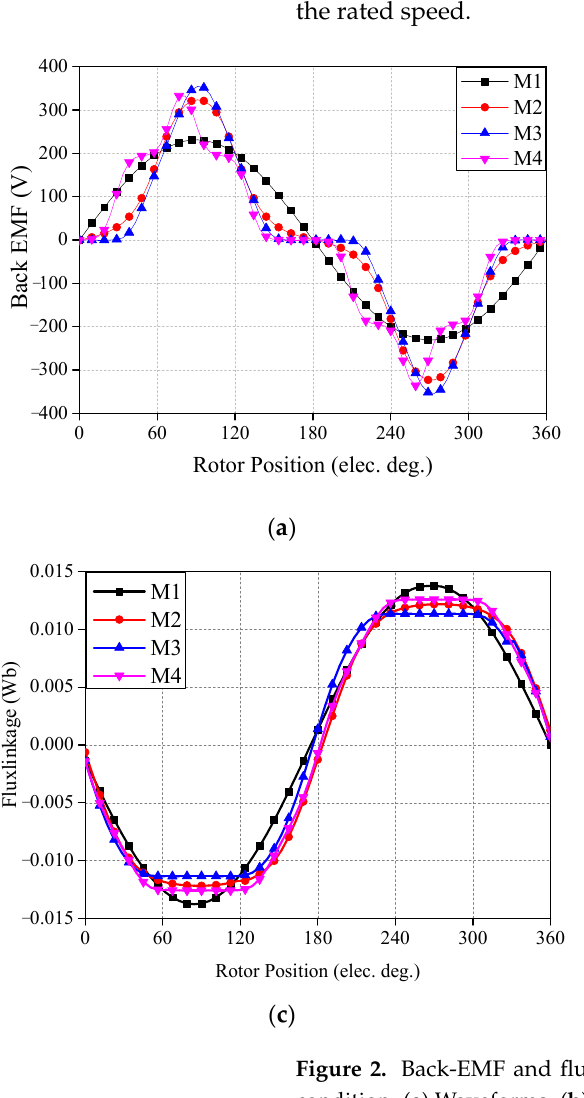
Figure 2. Back-EMF and flux-linkage waveforms for HSPMSM with different rotors at no-load condition. ( a ) Waveforms. ( b ) spectral analysis; ( c ) flux linkage waveform. The output torque of the PMSM can be obtained